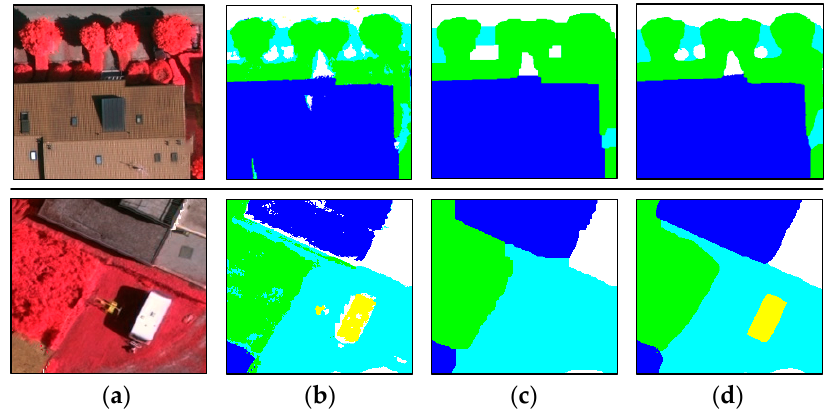
Figure 6. The results of two testing areas refined using short-range CRF and long-range FCCRF methods respectively. ( a ) the multispectral image; ( b ) the classification result from the RFE model; ( c ) the refined result from the short-range CRF model; ( d ) the refined result from the long-range FCCRF model.